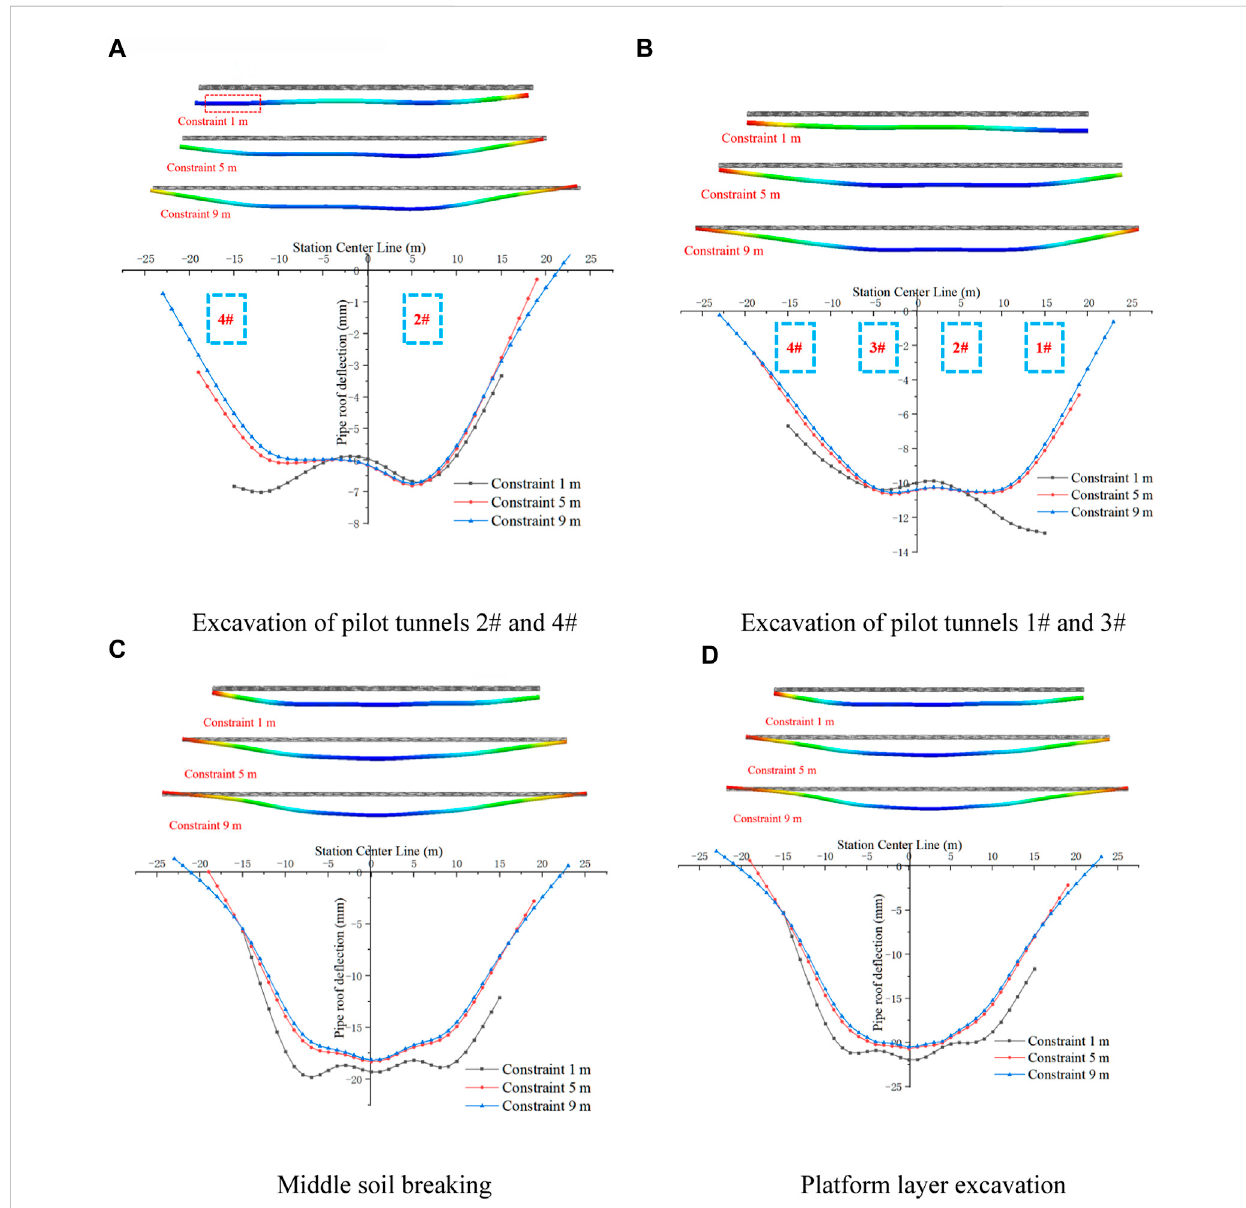
FIGURE 19 Surface subsidence curve under different pipe